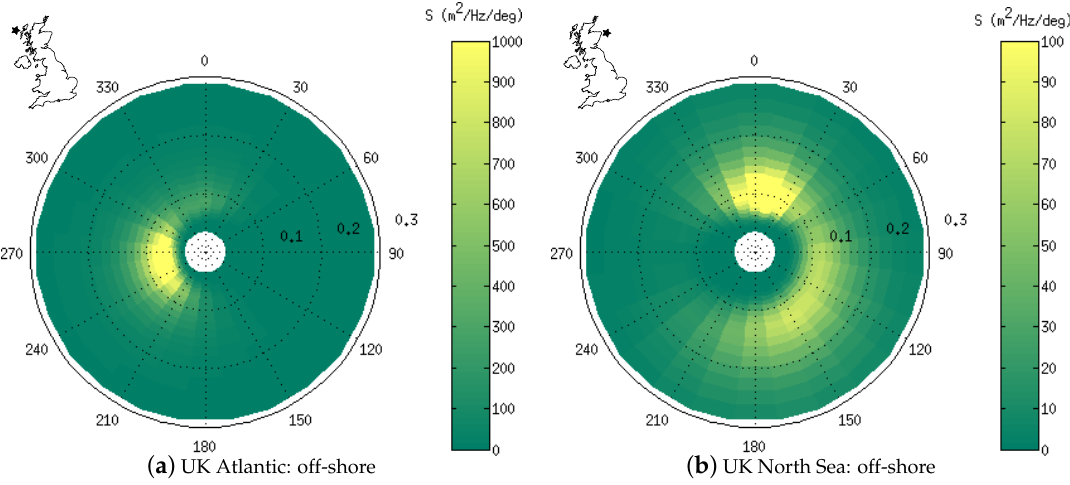
Figure 5. Average wave spectra at the UK off-shore sites. The polar angle axis indicates the direction of the spectral bin in nautical convention; the radial axis indicates the frequency of the spectral bin in